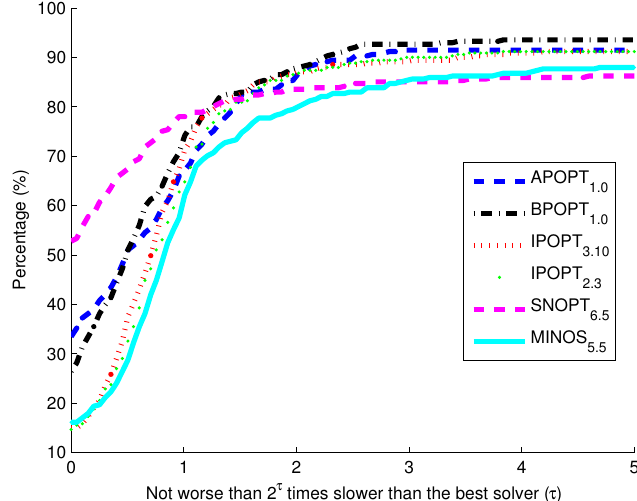
Figure 10. Benchmark solver results for biological models comparing six solvers over 341 curated models from the biomodels